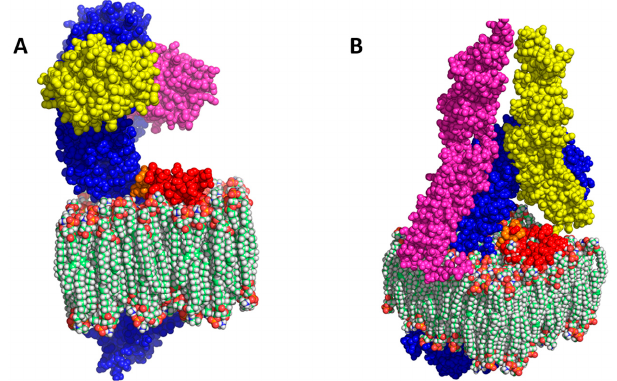
Figure 4. Bioinformatics modelling of I329L putative dimerization domain (PDDTM). A model of the PDDTM was created from the original I329L model and overlaid on one of the TLR dimer chains of TLR4 ( A ) (PDB: 3FXI) and TLR5 ( B ) (PDB: 3J0A). The structural similarity suggests an I329L-TLR interaction that would prevent the formation of signalling TLR homodimers. The I329L PDDTM is in red, with the dimerization motif in orange. TLR4 and TLR5 are in blue. The interacting molecules in the TLR4 model, visualized in yellow and pink, are the co-interactor MD2. In the TLR5 model, the same colors label flagellin (TLR5 ligand).